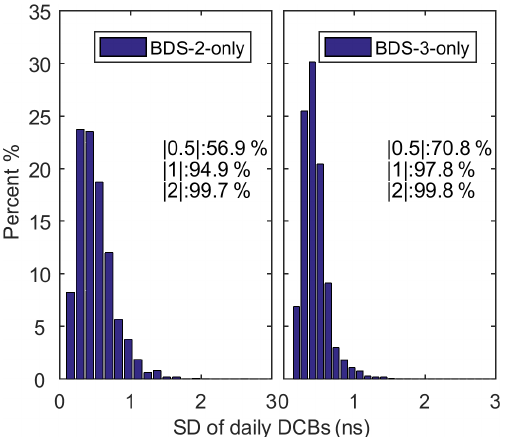
Figure 10. Statistical distribution of intraday SD of receiver DCB by using BDS-2-only and BDS-3-only